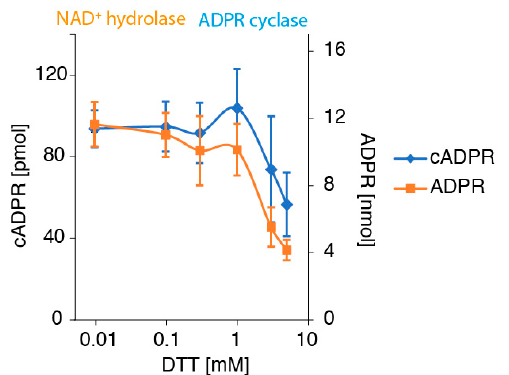
Figure 5. DTT inhibits the production of ADPR and cADPR by LP-1 cells in a dose-dependent manner. LP-1 cells were incubated for 10 min with the indicated concentrations of DTT before addition of NAD + (500 μ M) and further incubation for 60 min at 37 °C. Concentrations of ADPR and cADPR in cell supernatants were determined by HPLC, as in Figure